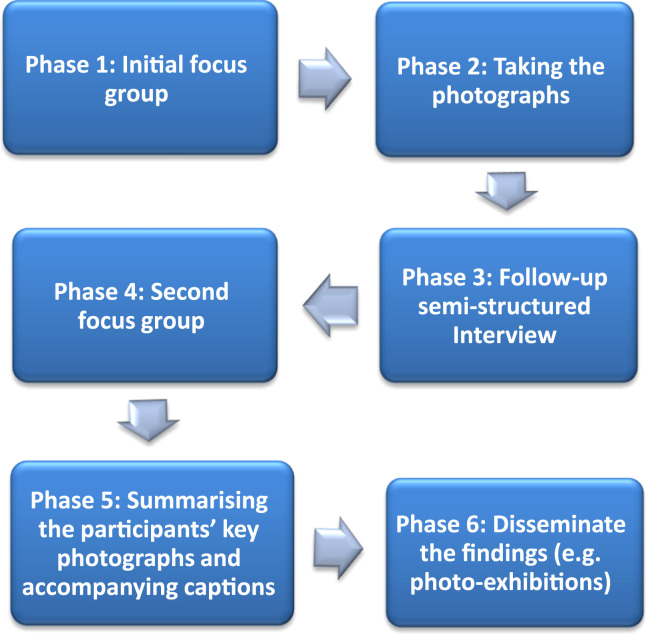
Phases of the photovoice process adopted in this study. Adapted from Nykiforuk et al. (2011).